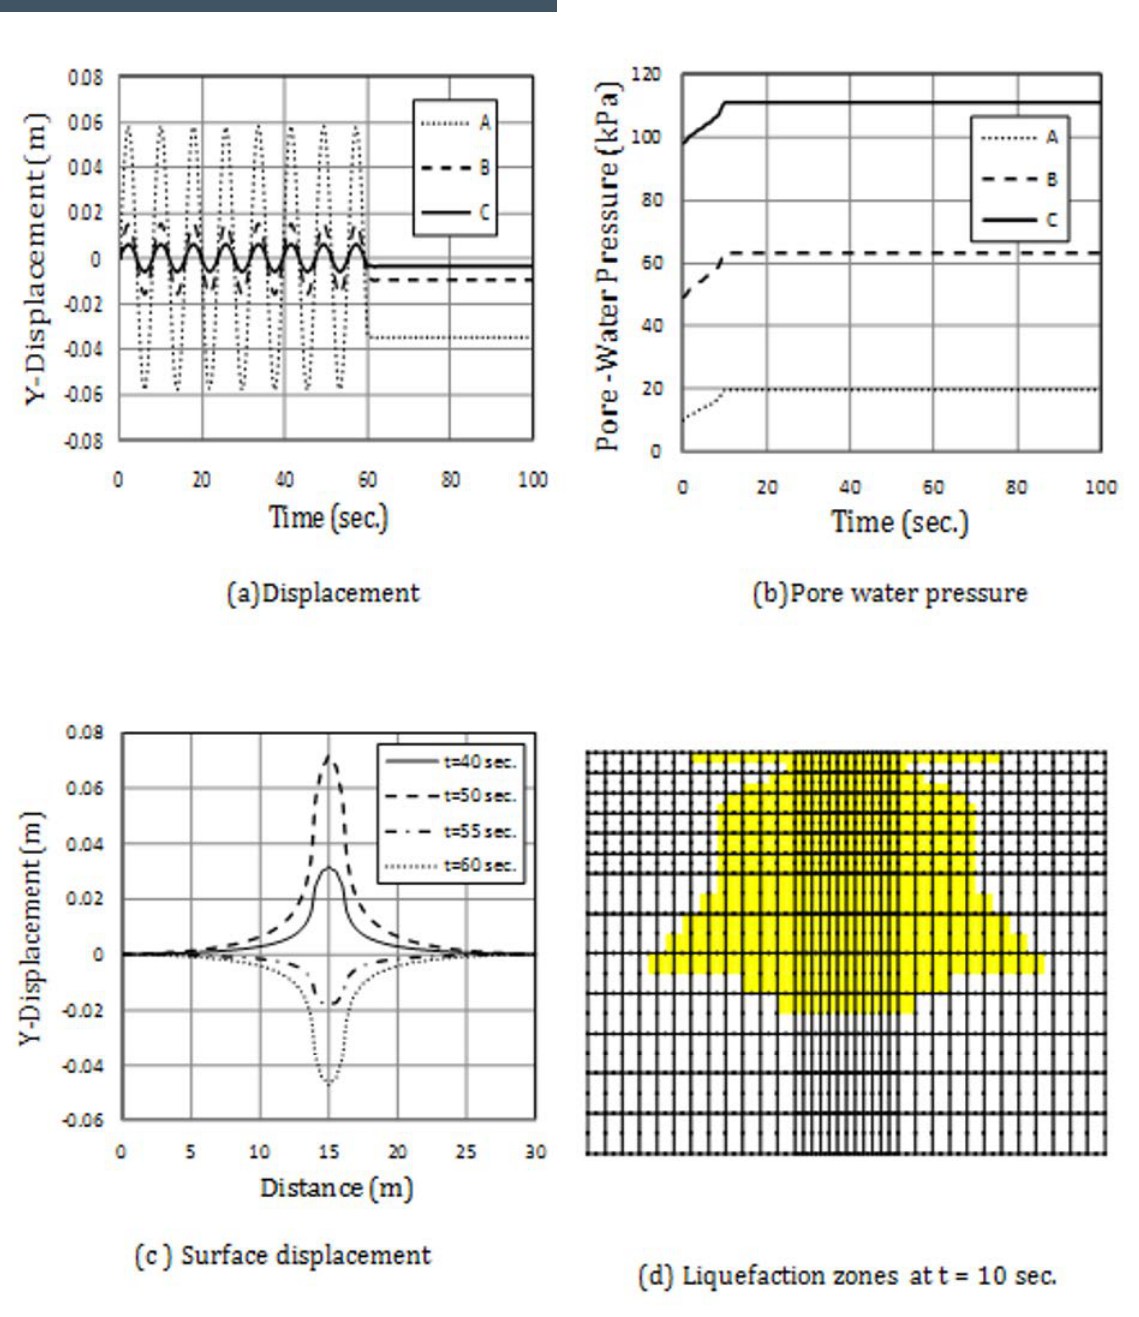
Figure 18. Dynamic response of the foundation to harmonic load, a